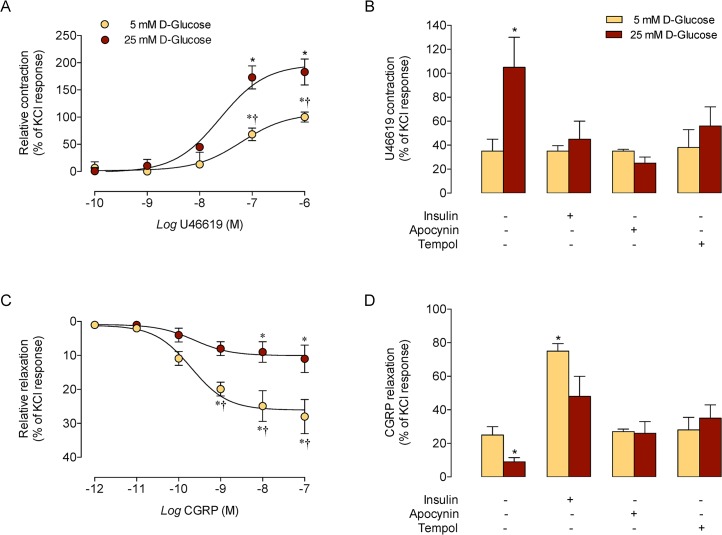
Apocynin, tempol and insulin block high D-glucose effect on human umbilical vein ring reactivity.A, Response of human umbilical vein rings to U46619 incubated (5 minutes) in 5 or 25 mmol/L D-glucose (24 hours). Relative responses are given as a percentage fraction of the initial vessel response to KCl (see Methods). B, Maximal response of umbilical vein rings to 100 nmol/L U46619 as in A in the absence (–) or presence (+) of 1 nmol/L insulin, 100 μmol/L apocynin or 1 mmol/L tempol. C, Response of vein rings to CGRP as in A. D, Maximal response to 10 nmol/L CGRP as in B. In A and C, *P<0.03 versus corresponding values at lower concentrations of either U46619 or CGRP. †P<0.05 versus corresponding values in 25 mmol/L D-glucose. In B, *P<0.02 versus all other values. In D, *P<0.02 versus all other corresponding values. Values are mean ± S.E.M. (n = 4–7).